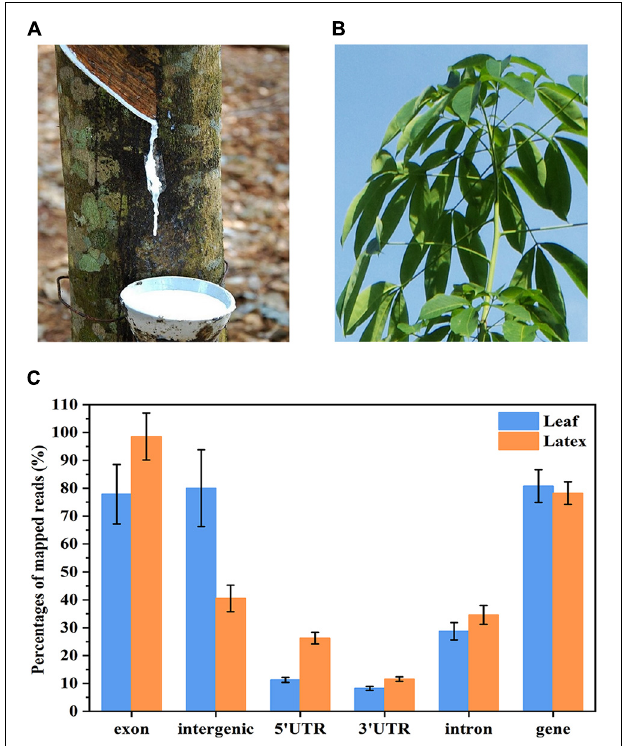
FIGURE 1 | Ribonucleic acid (RNA) sequencing of the nuclei prepared from (A) latex and (B) leaves of the rubber tree. The reads were mapped onto the rubber tree genome and (C) percentages of the mapped reads on each region were calculated. As the read is 150 nt, one reads may map onto several